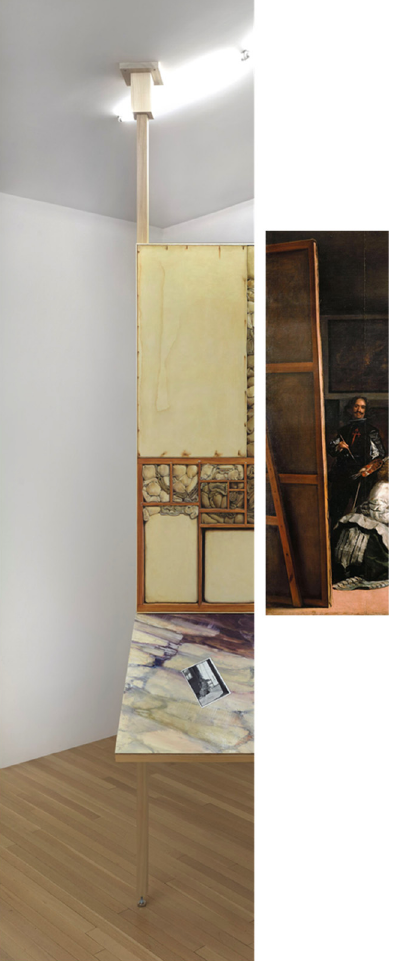
Figure 8. Details, canvases ( Left ) (McKenzie 2021). ( Right ) (Vel á zquez